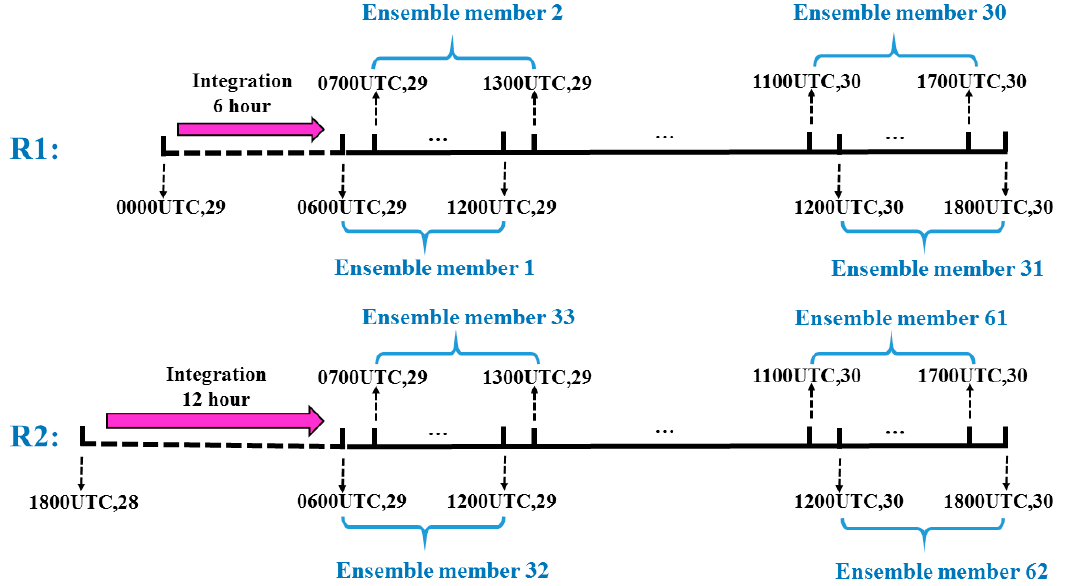
Figure 3. The method of historical sampling for satellite data assimilation. See text for details.